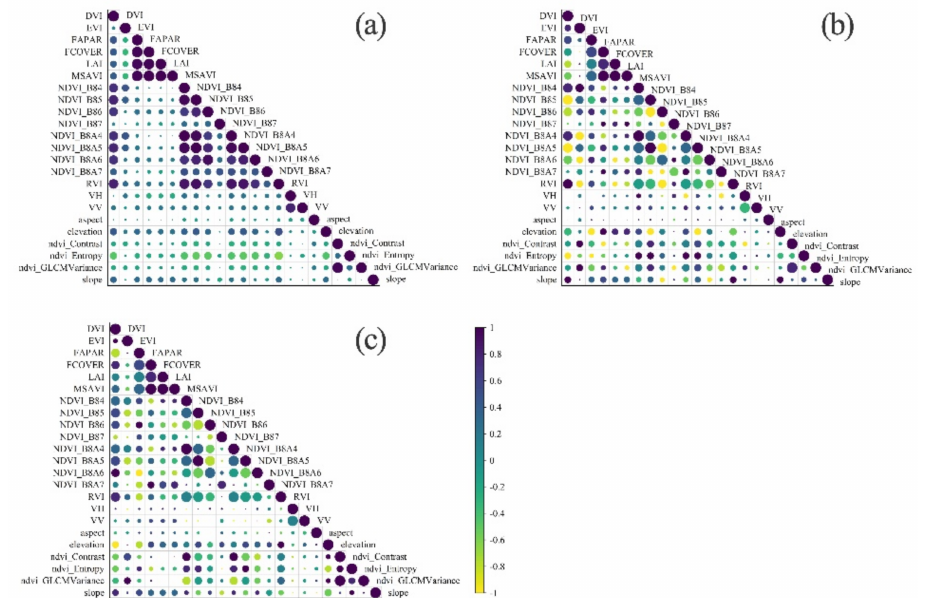
Figure 11. Correlations between variables for each optimal set. ( a ) CF, ( b ) BF, and ( c ) MF. Color bar indicates the correlation